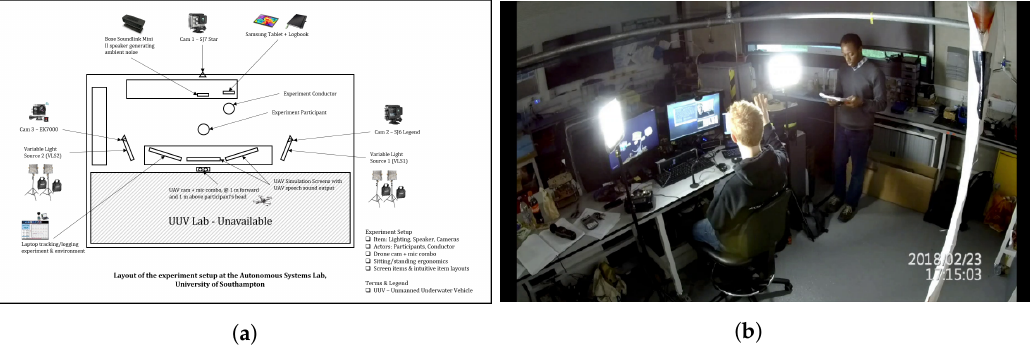
Figure 1. Setup and conducting the experiment. ( a ) Experiment setup layout, ( b ) Conducting the